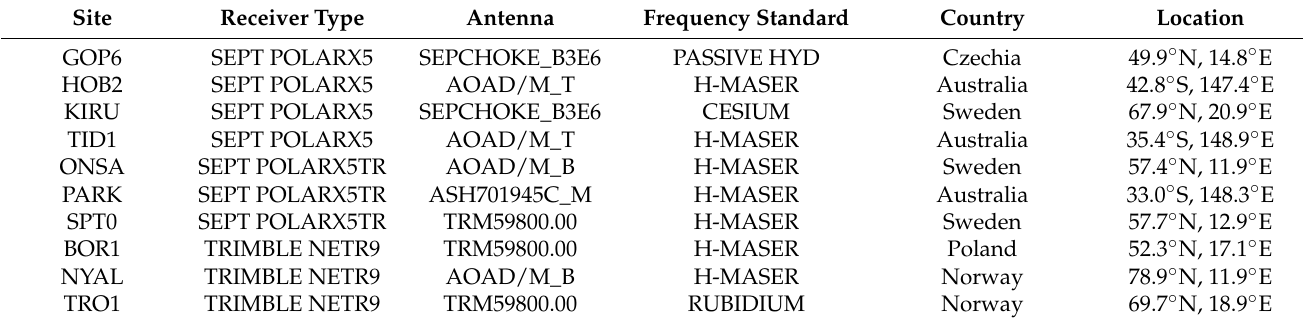
Table 1. Information of utilized BDS stations in the